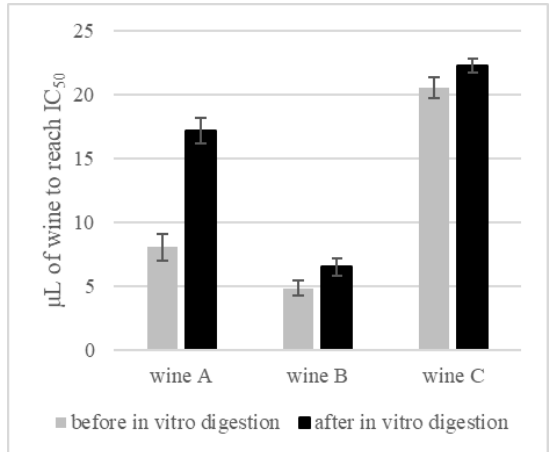
Figure 7. Amount of wine (μL) needed to obtain 50% inhibition of alpha -glucosidase (IC 50 ).